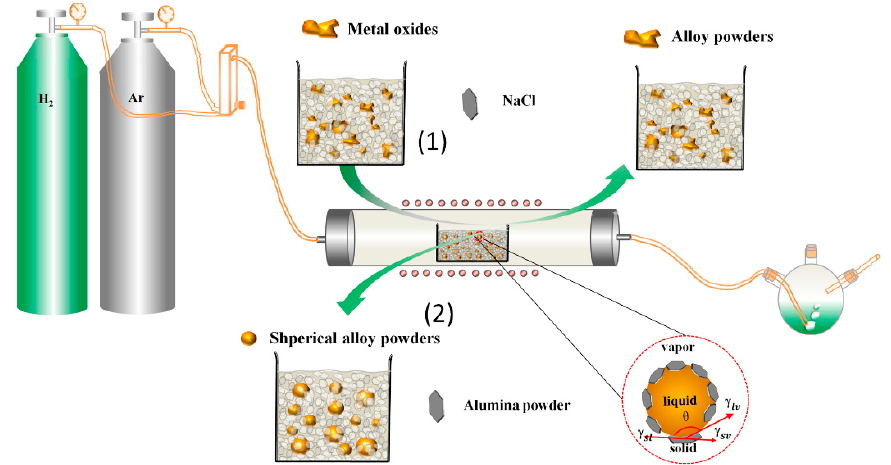
Figure 1. Schematic illustration of ( 1 ) pre-alloy from the reduction of mixted metallic oxides on NaCl, ( 2 ) spherical alloy powders fabricated at 1823 K on alumina, enlarged view of the triple solid–liquid–vapor junction of metal droplet.